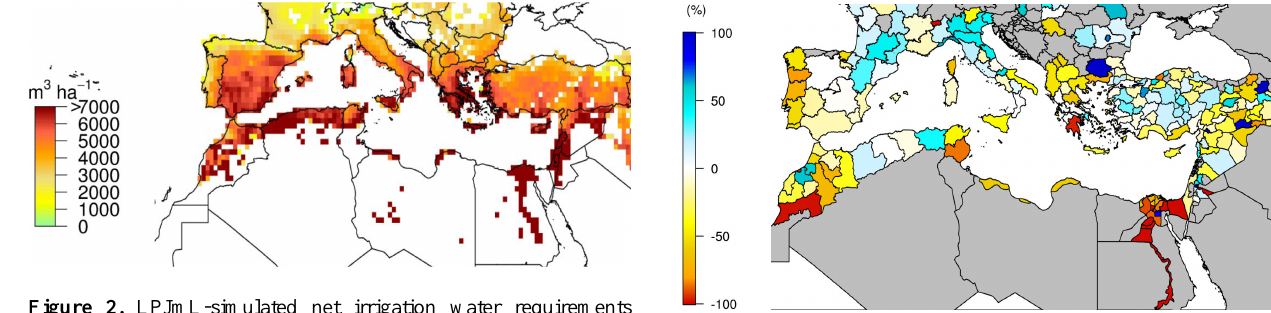
Figure 3. Comparison of irrigation consumptive water use from Siebert et al. (2010) and net irrigation water requirements computed in this study as a percentage of the Siebert et al. (2010) values. Neg- ative (positive) values indicate higher (lower) values in their